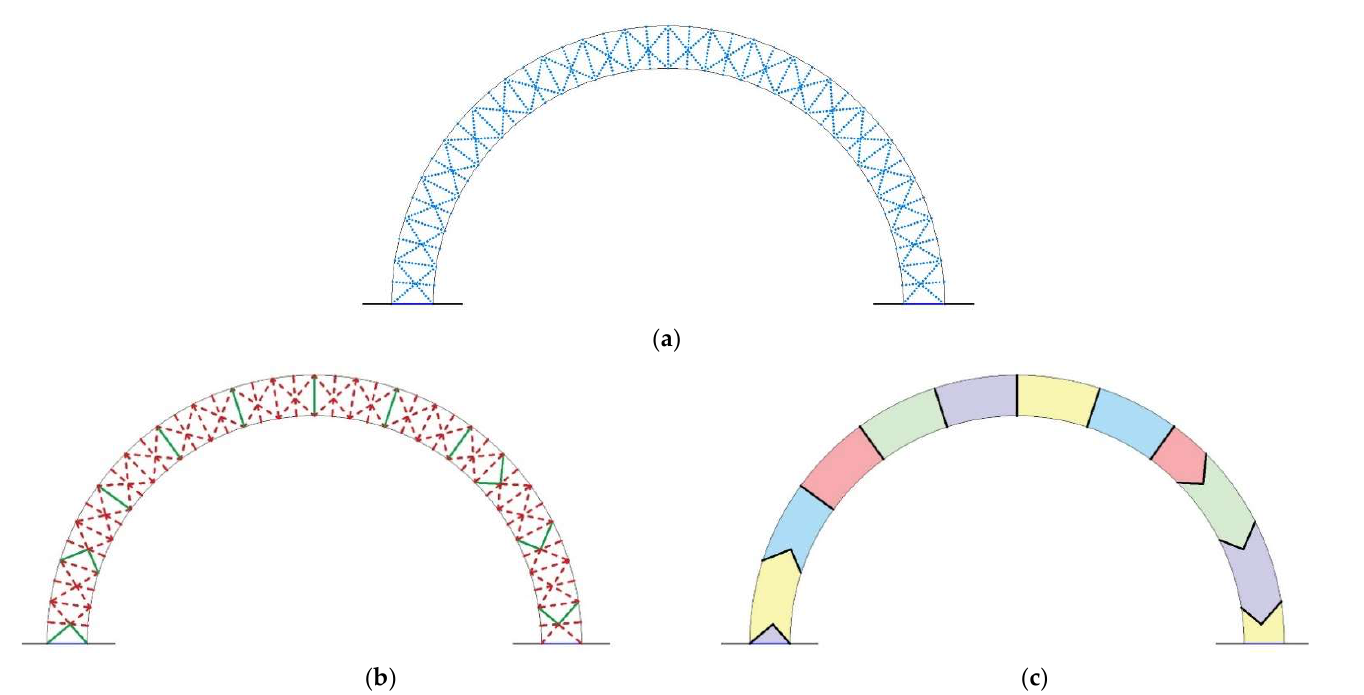
Figure 12. (a) A dense network of neutral interfaces, allowing the (b) modelling of arch-shaped Figure 12. ( a ) A dense network of neutral interfaces, allowing the ( b ) modelling of arch-shaped structures having joints with complex shapes that can generate (c) interlocking concave segments. structures having joints with complex shapes that can generate ( c ) interlocking concave